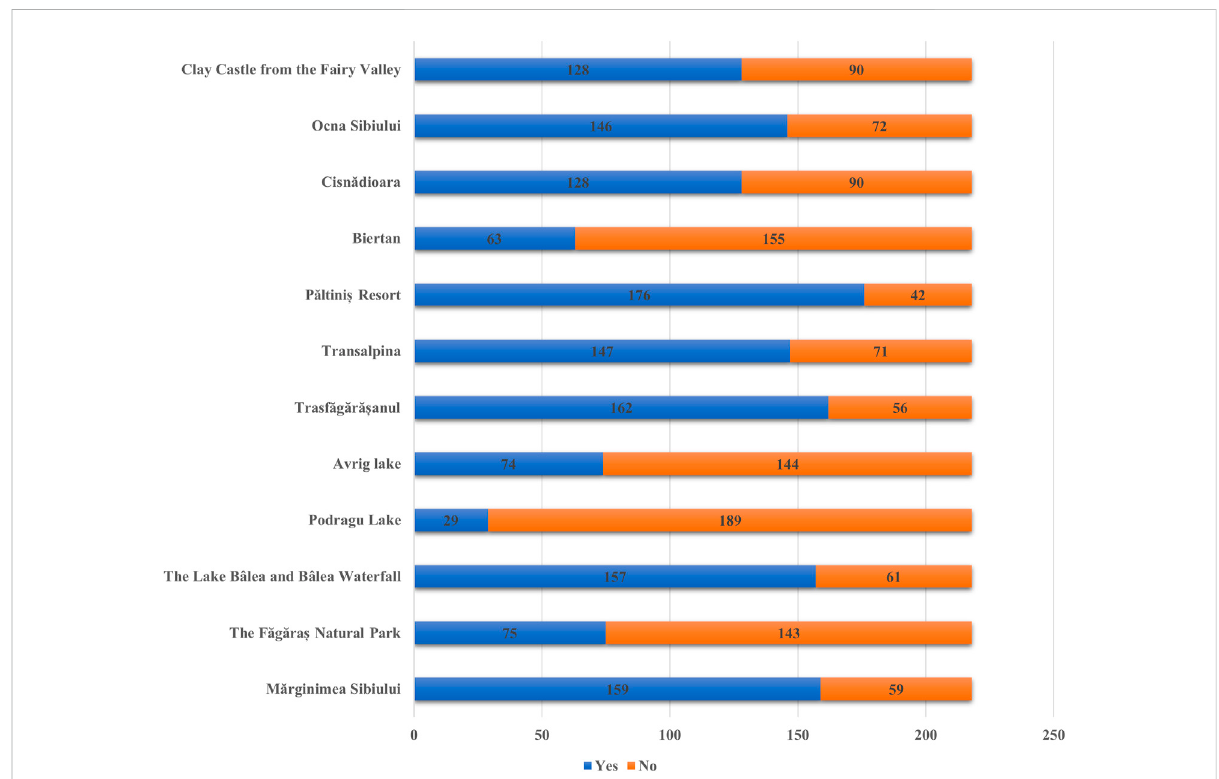
FIGURE 6 Tourism destinations in Sibiu County visited by young people in 2020 and